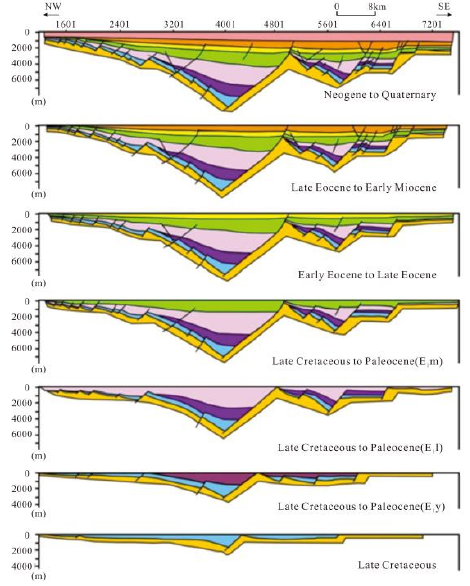
Figure 2. The tectonic evolution characteristics of the Lishui Sag (according to CNOOC).